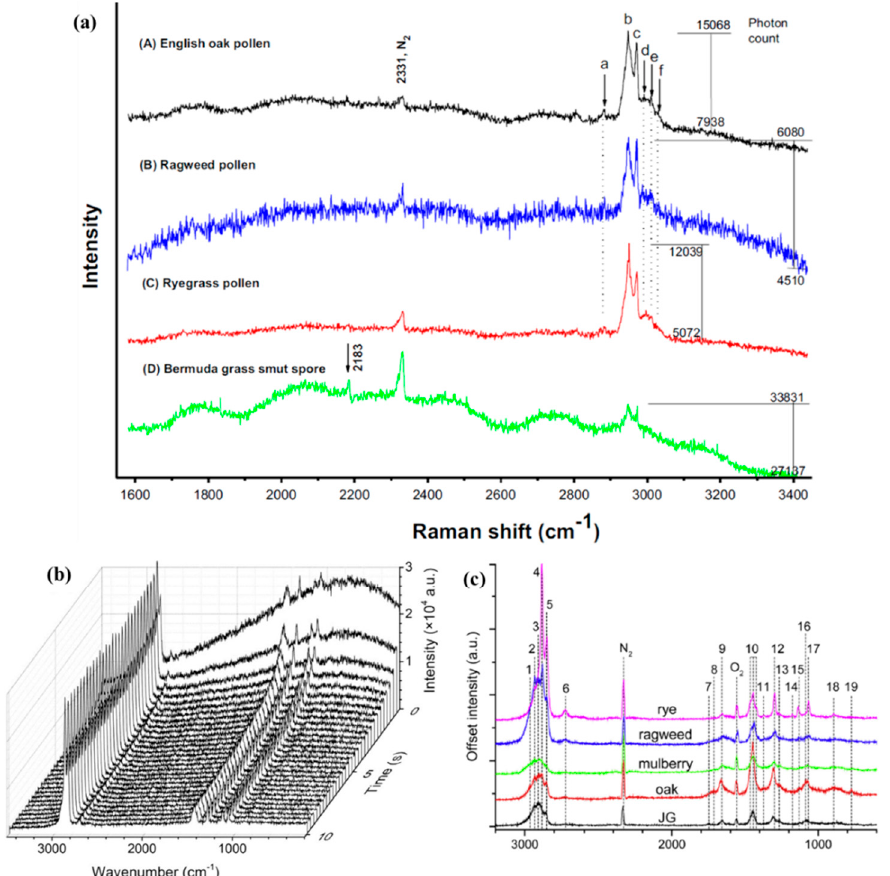
Figure 5. ( a ) Raman spectra of single, trapped spores. (Reproduced with permission from ref. [49]. Copyright 2015, Elsevier). ( b ) Raman spectra of trapped RhB-PEMS. (Reproduced with permission from ref. [50]. Copyright 2017, Elsevier). ( c ) Raman spectra of various types of single, trapped pollen and spore. (Reproduced with permission from ref. [36]. Copyright 2018, Elsevier).